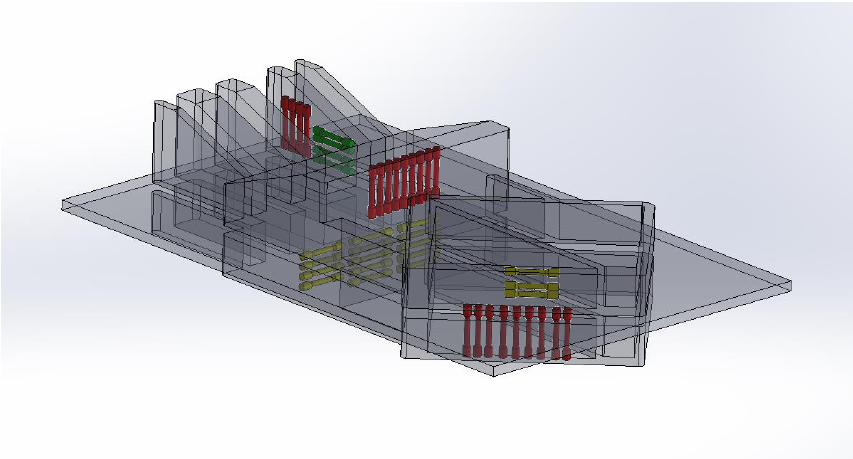
Figure 3. 3D representation of the as-printed part with the tensile test specimen locations isolated. Red are vertically oriented specimens in the z -direction, yellow are horizontally oriented across the body in an x - y plane, and green are purely horizontal specimens either in x or y -directions. The part geometry measures 40 cm in width, 72 cm in length, and 18 cm in